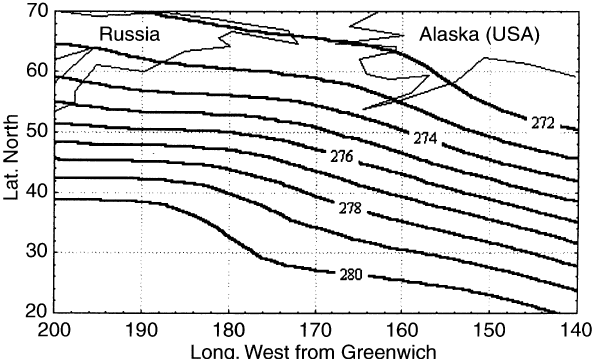
Fig. 4. Temperature pattern (in (cid:14) K) in July 1956 over the North Pacific area. Characteristic situations, among those analysed, repre- senting maximum contribution in this month for the seventh term